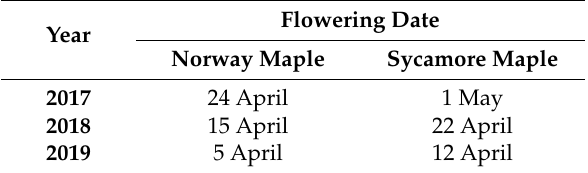
Table 1. Dates of flowering of Norway maple and sycamore maple in this